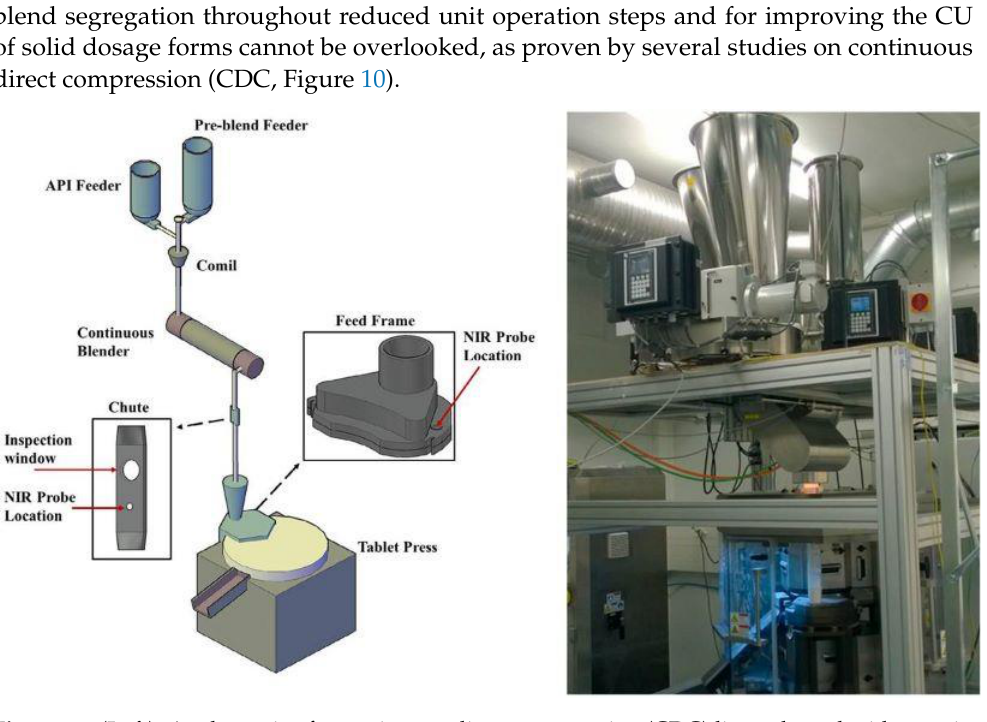
Figure 10. ( Left ): A schematic of a continuous direct compression (CDC) line, adapted with permission from [90]; published by Elsevier, 2019. ( Right ): An overview of a CDC line setup, adapted with permission from [21]; published by Elsevier, 2019.